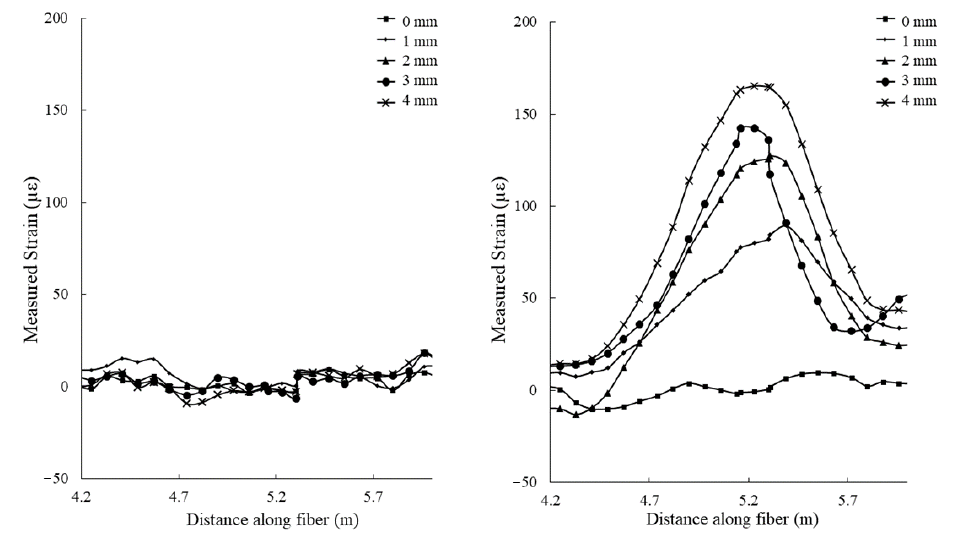
Figure 18. Strain measurements taken for incremental displacement values (from 0 to 4 mm) during the shear deformation experiment using a standard fiber optic cable ( left ) and the hybrid fiber optic cable ( right ).